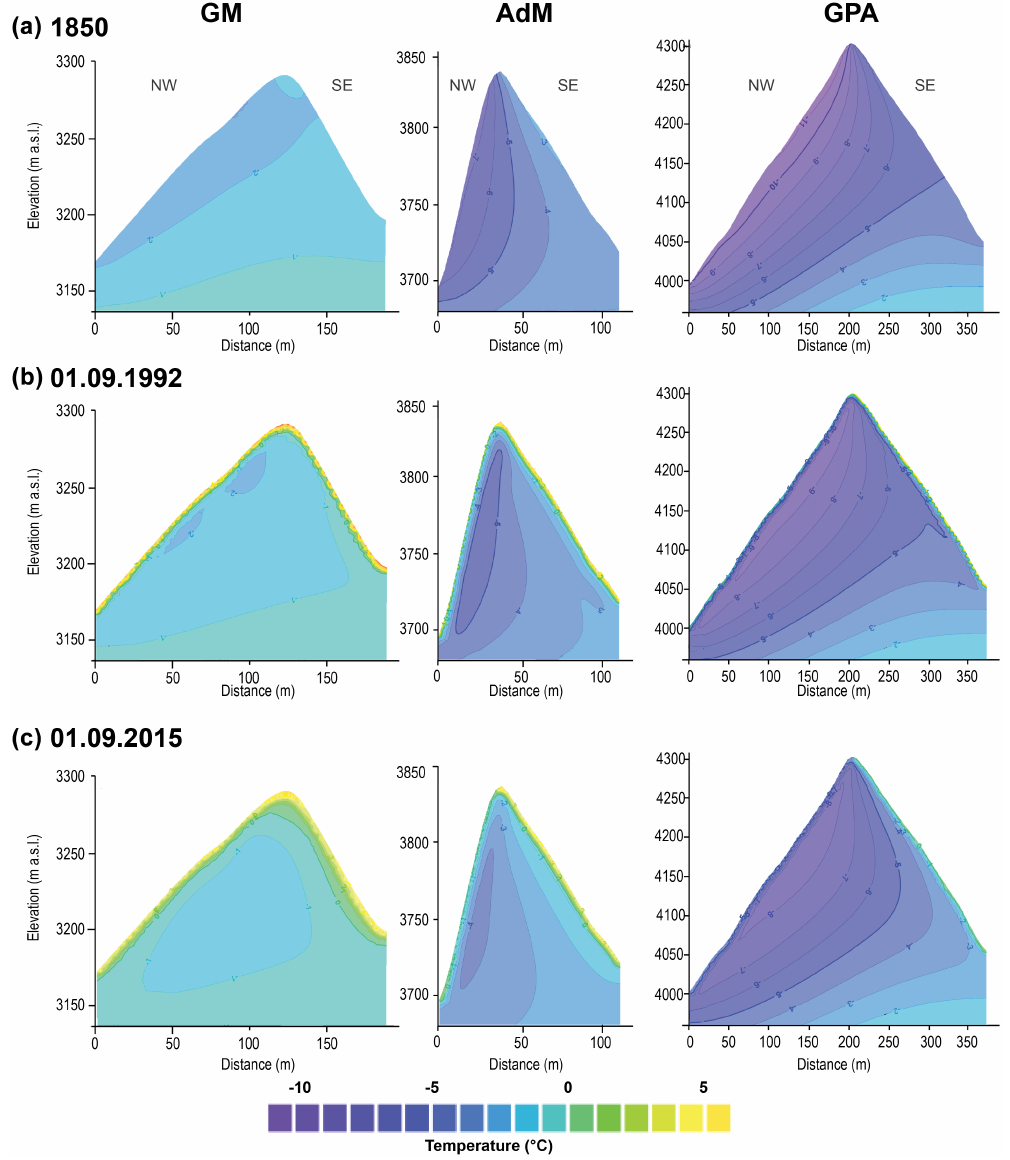
Figure 5. Initial steady-state (a) conditions and time-dependent conditions in September 1992 (b) and September 2015 (c) for the three studied sites (note differing figure